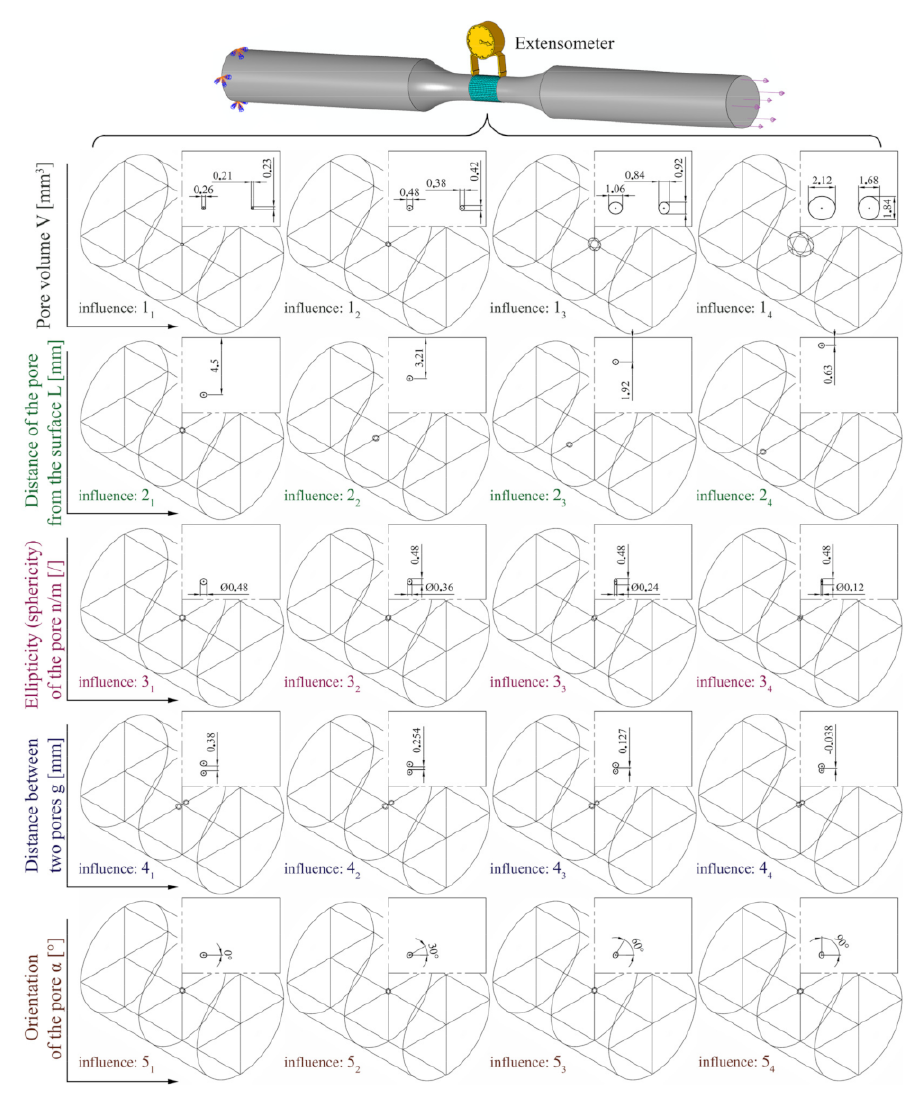
Figure 7. Analysis of different geometric influences of porosity on fatigue